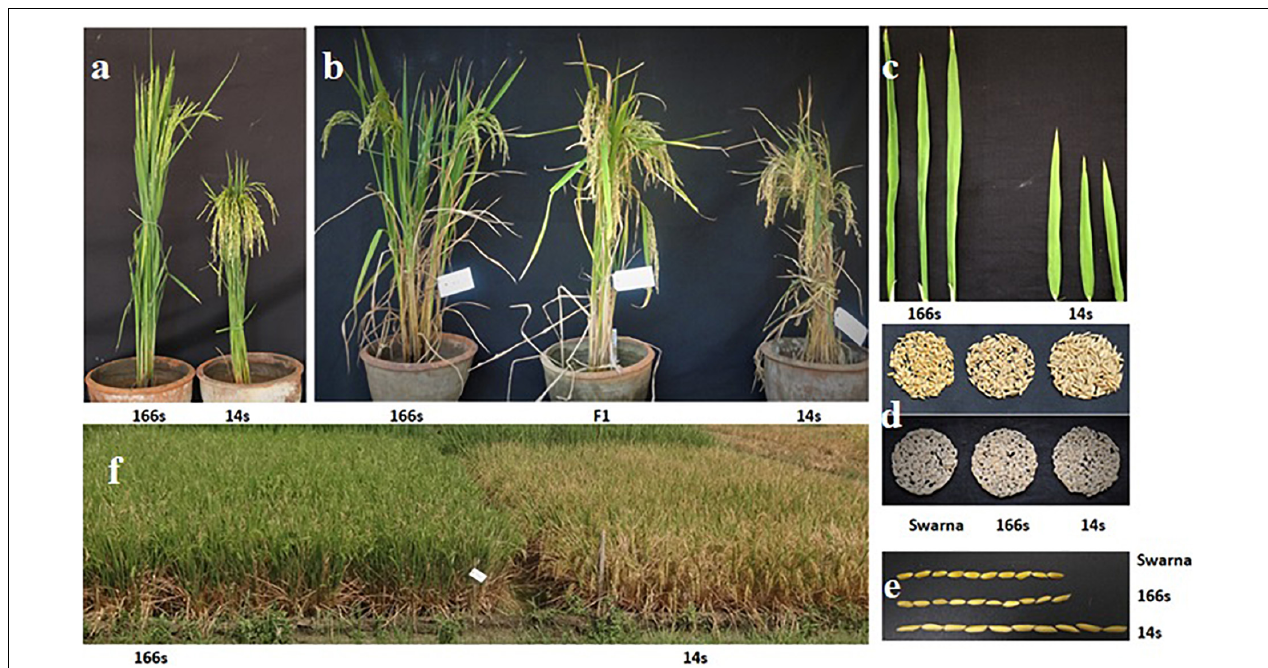
FIGURE 1 | Phenotypic characteristics of parental lines, plant, and grain traits of 166s, 14s, and Swarna. (a) Parental lines 166s and 14s, (b) 166s, 14s parents with F 1 (166s × 14s hybrid-middle one) plant, (c) Flag leaf length of 166s and 14s, (d,e) Swarna, 166s and 14s grains with husk and without husk and length of grains, (f) Field view of 166s and